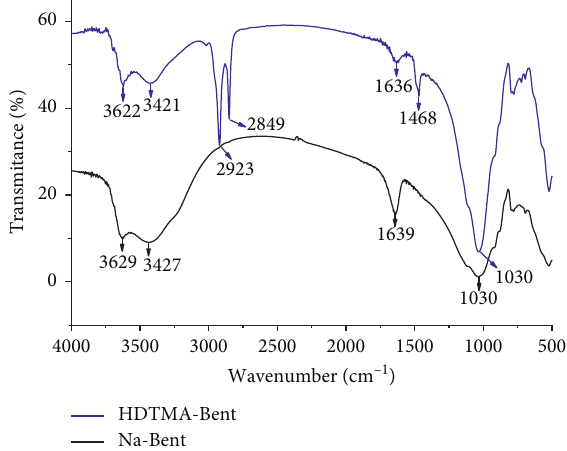
Figure 2: FT-IR spectra of sodium bentonite (Na-Bent) and organobentonite (HDTMA-Bent).